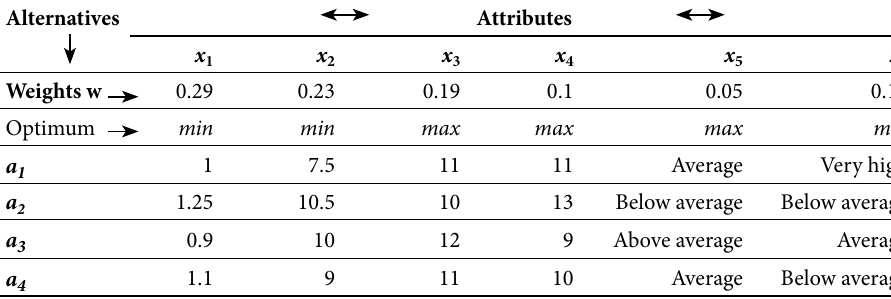
Table 1. Initial decision-making